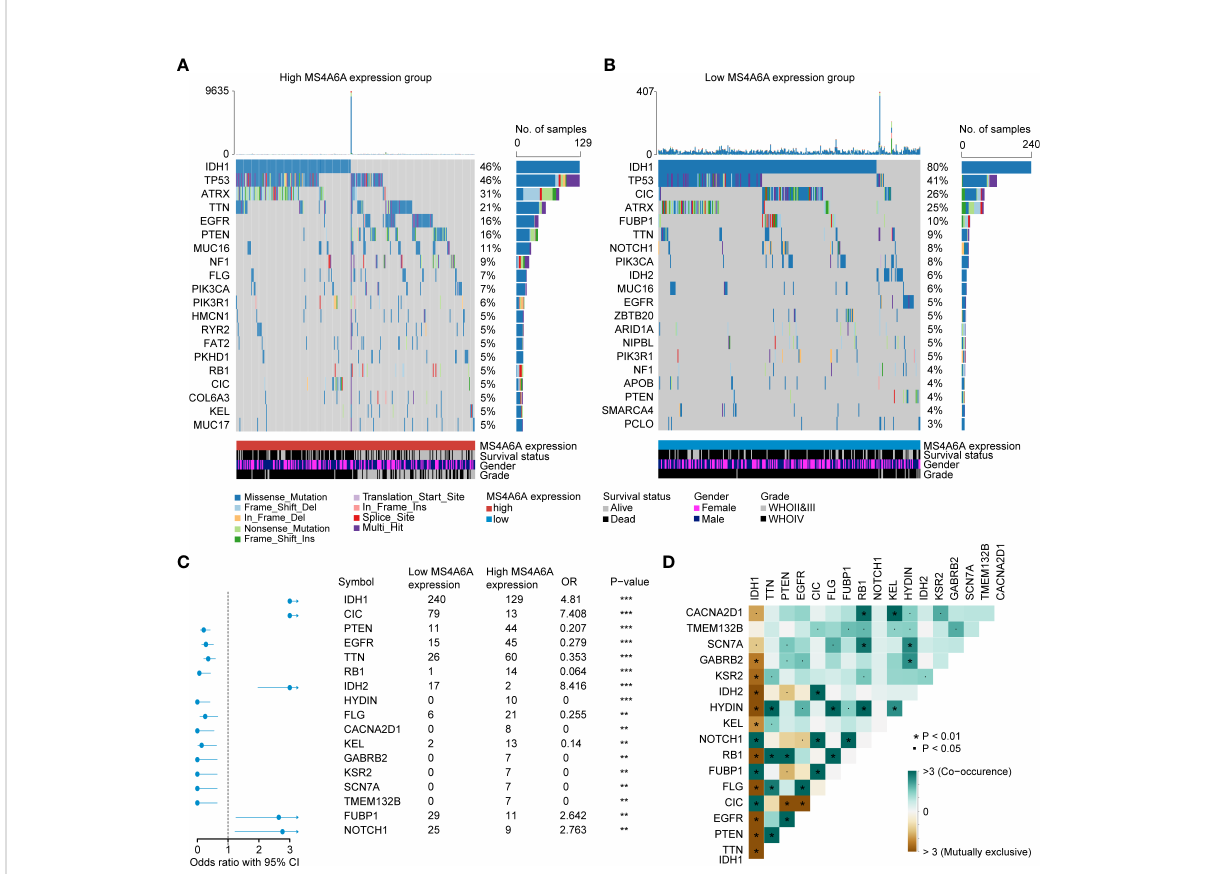
FIGURE 8 Correlation between the TIMEscore and somatic variants.The oncoPrint plots of gene mutant frequency in high (A) and low (B) MS4A6A expression group. Forest plot of differentially mutated genes after divided by MS4A6A (C) . Corplot of mutually exclusive or co-occurring genes, tested by pairwise Fisher ’ s exact test (D) (* p < 0.05; ** p < 0.01; *** p <